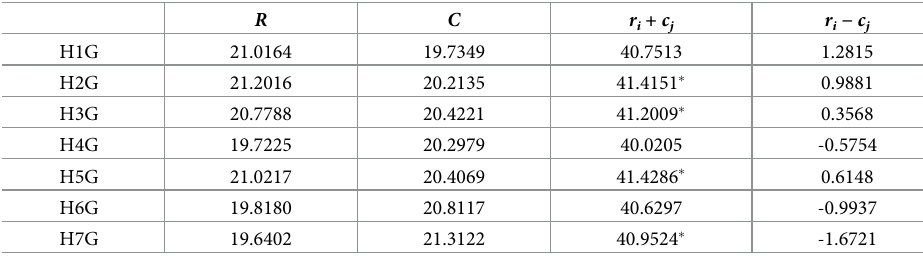
Table 5. The direct and indirect influence of